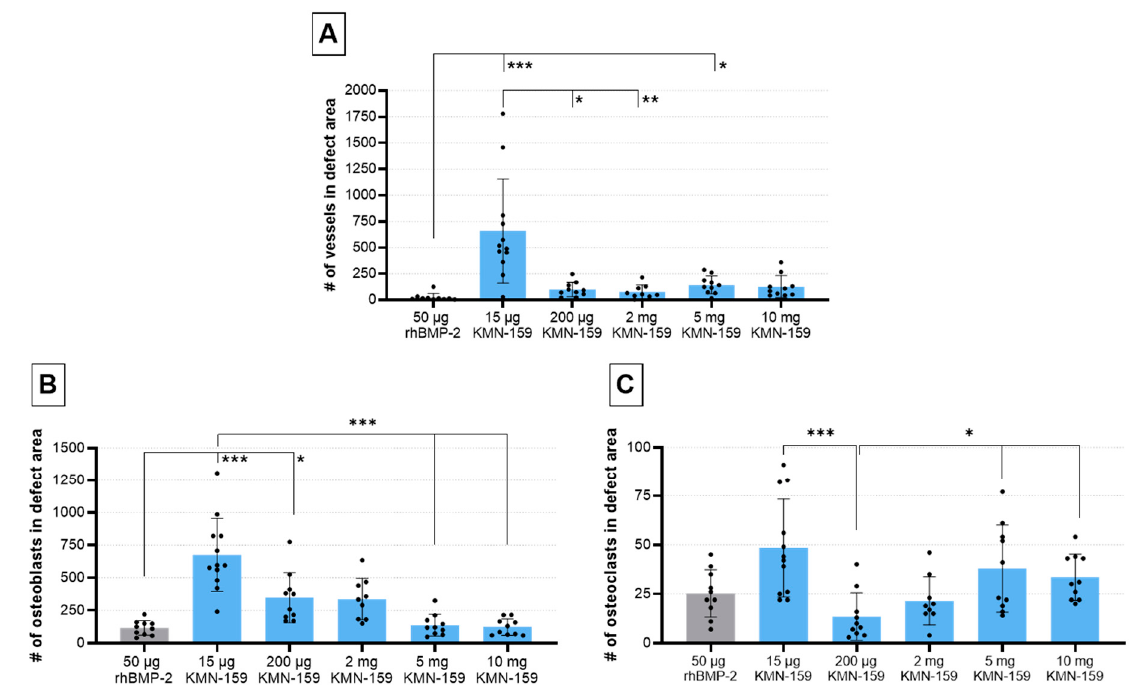
Figure 6. Histological evaluation of vascularization and bone cell markers 12 weeks after surgery. Semi-quantitative analysis of ( A ) α -smooth muscle-stained vessels, ( B ) ALPL-stained osteoblasts and ( C ) TSP-stained osteoclasts within the defect area (mean ± SD; Kruskal-Wallis following Dunn’s post hoc test: *** p ≤ 0.001, ** p ≤ 0.01, * p ≤ 0.05).